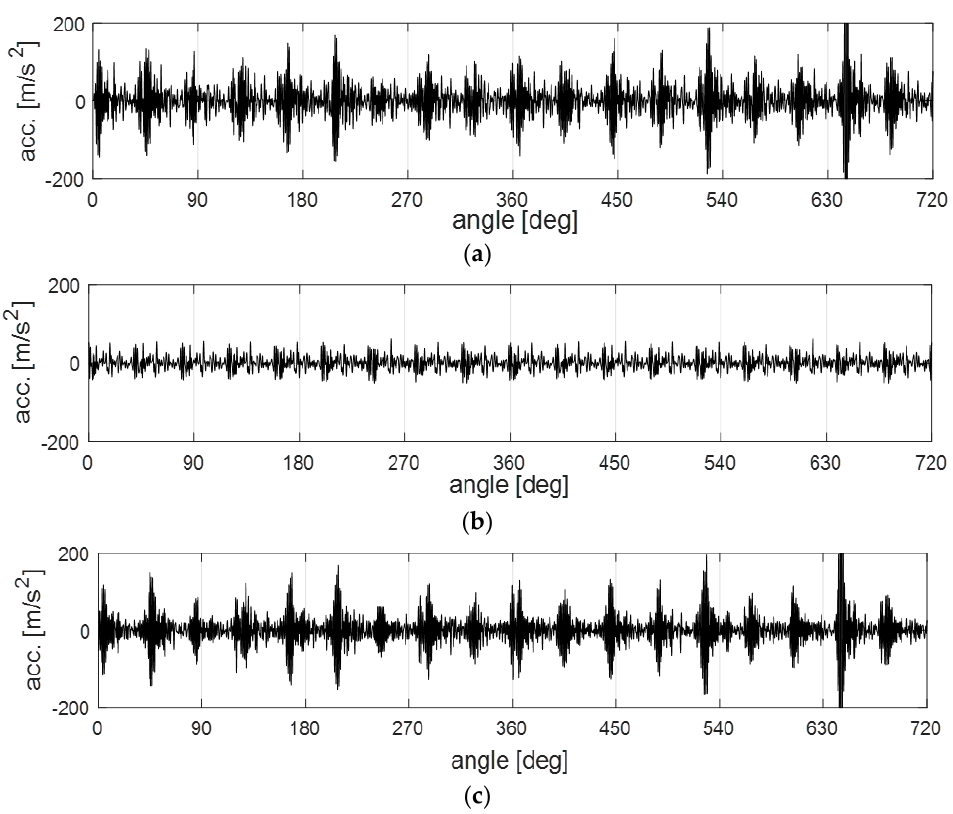
Figure 6. ( a ) Raw signal, ( b ) synchronous average, and ( c ) residual signal for the signal acquired with sensor 2 in the case of the flawless pump (1500 r/min and 150 bar).